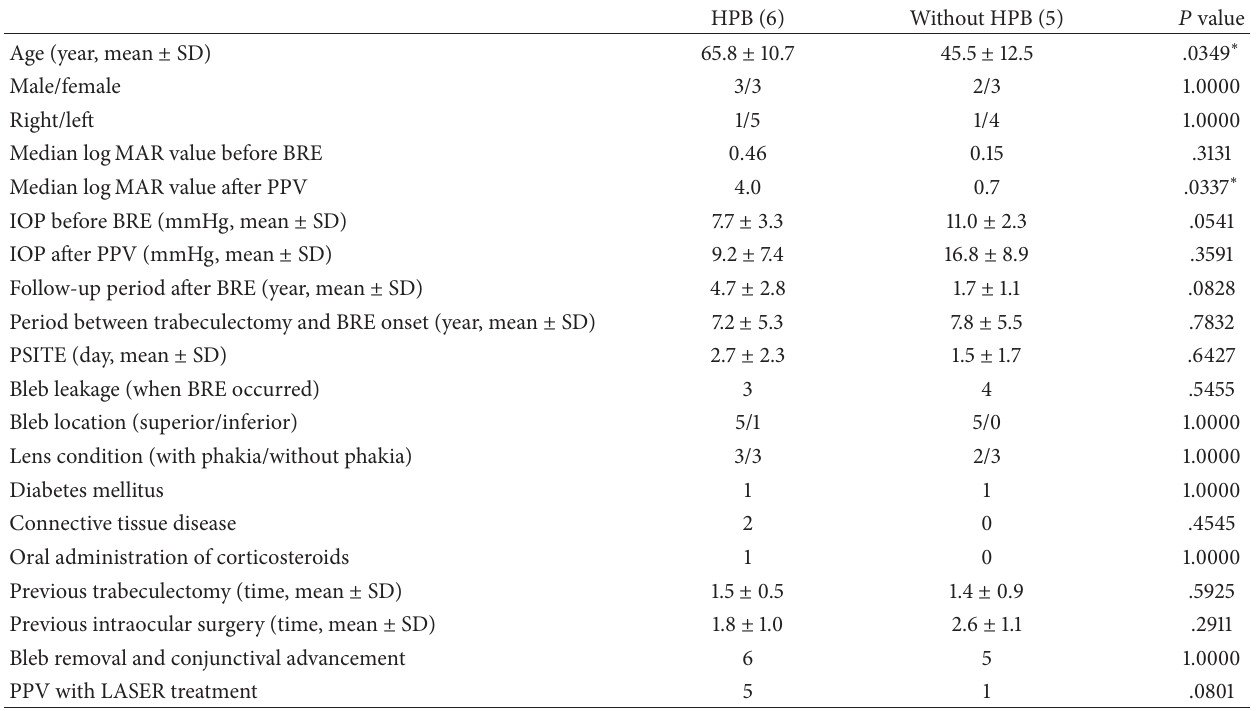
Table 3: Comparison with or without highly pathogenic